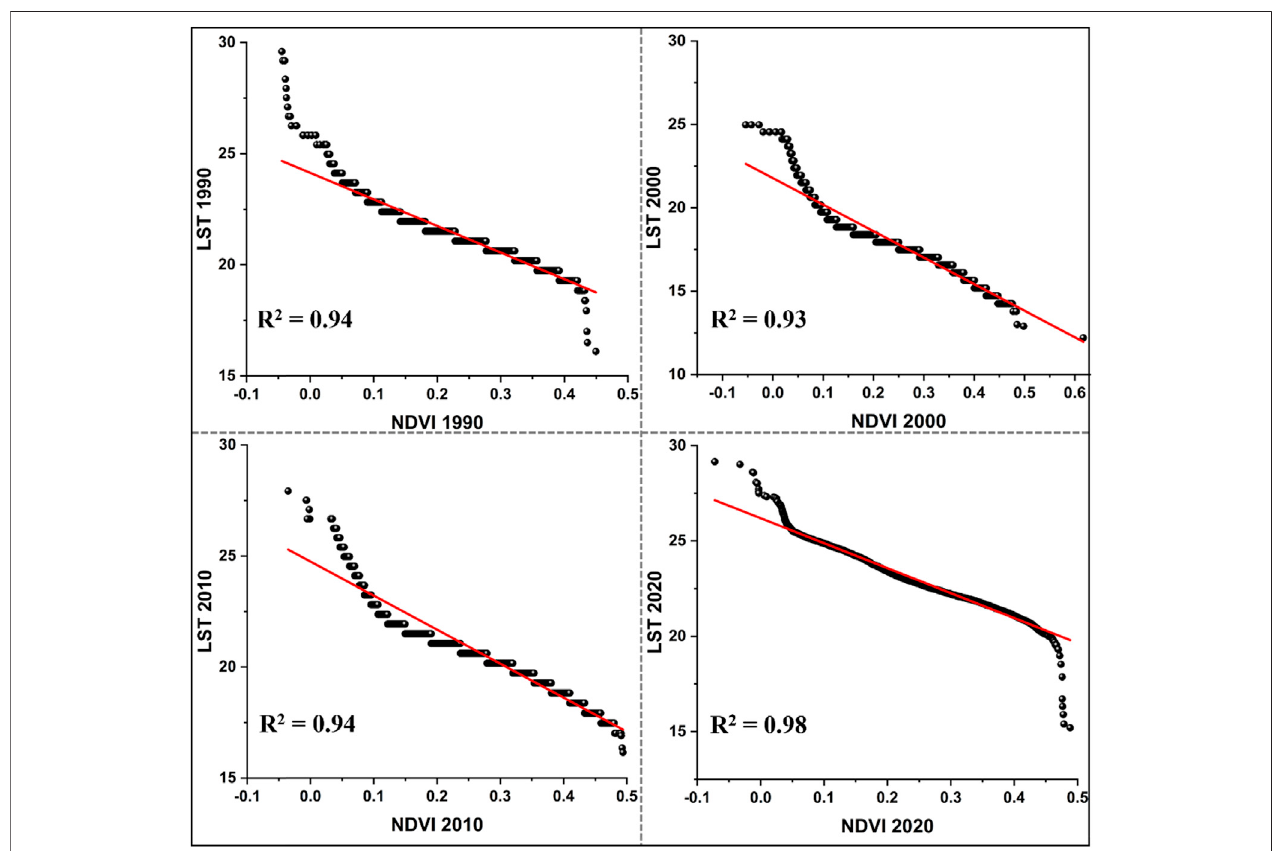
FIGURE 6 | Correlation between LST and NDVI for the years 1990, 2000, 2010, and 2020.